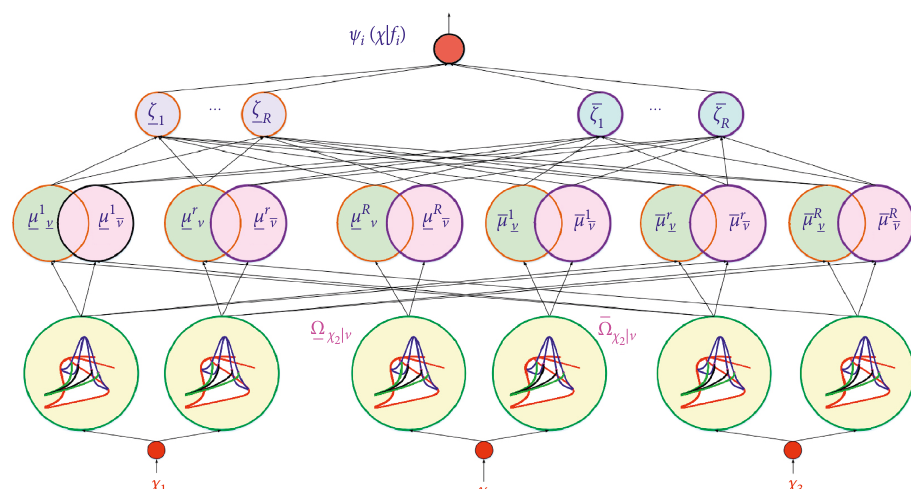
Figure 3: A schematic view of the T3-FLS.